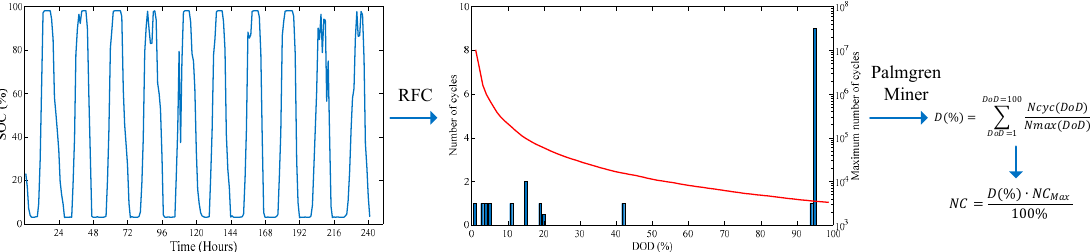
Figure 3. Definition of the equivalent number of full cycles ( NC ) from a partially cycled state of charge (SOC) evolution.